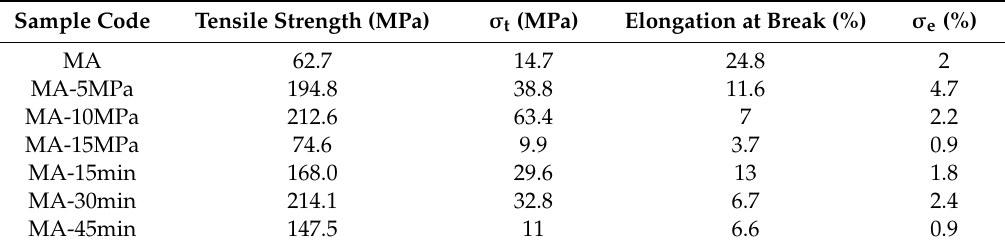
Figure 9. ( a ) Tensile strength and ( b ) elongation at break of the MA sample and the all-wood biocomposites with different hot-pressing pressures. Table 2. Tensile properties and standard deviation.